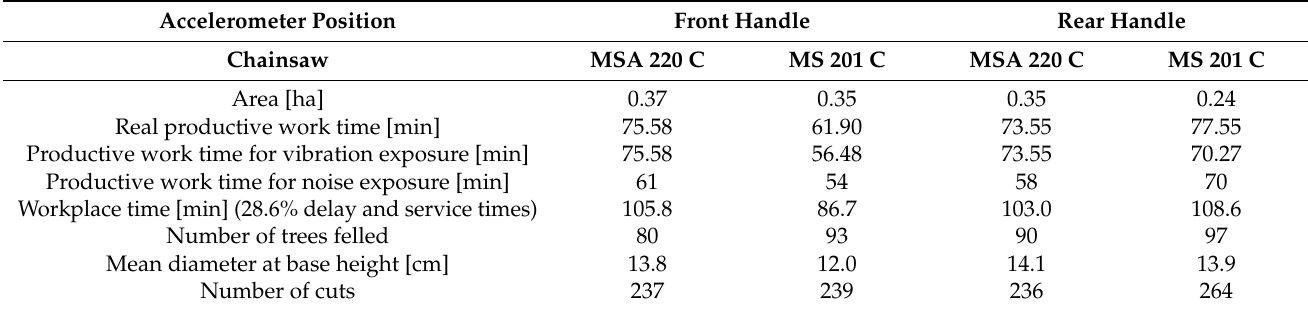
Table 2. Performance data for the eight cycles aggregated by the type of chainsaw and the position of the accelerometer [47]. Accelerometer